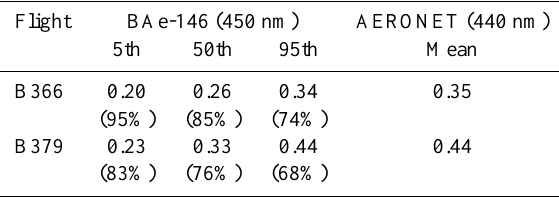
Table 5. Summary of Aerosol Optical Depth (AOD) values for flights B366 and B379. The values derived from the column in- tegrated measurements from the BAe-146 and AERONET are com- pared. The BAe-146 data corresponds to the vertical column above Cabauw up to 7500 m for B366 and 8500 m for B379. The percent- age values reported in brackets below the BAe-146 values represent the approximate fraction of the AOD located below 2000 m. The AERONET values are the total column integrated